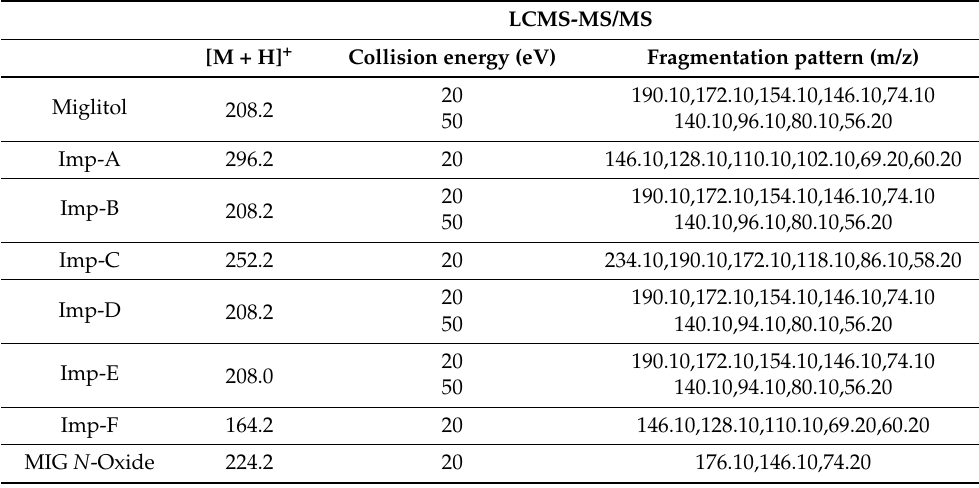
Table 3. Liquid chromatography mass spectrometry (LCMS) and tandem mass spectrometry (MS/MS) data of miglitol and other